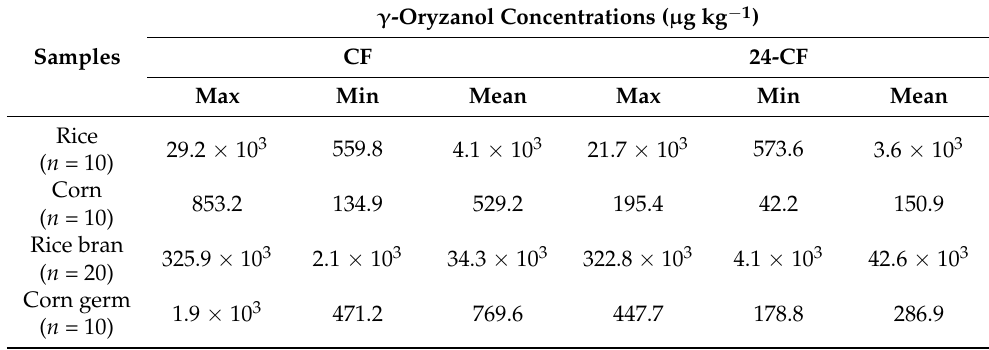
Table 3. Results for the determination of γ -oryzanol compounds in agriproducts.